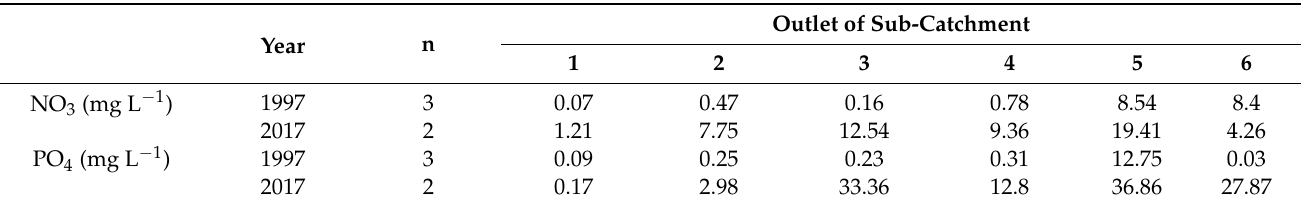
Table 9. Nitrate (NO 3 ) and phosphate (PO 4 ) concentrations (n = number of samples) at the outlet of sub-catchments 1–6 in 1997 and 2017. Outlet of n